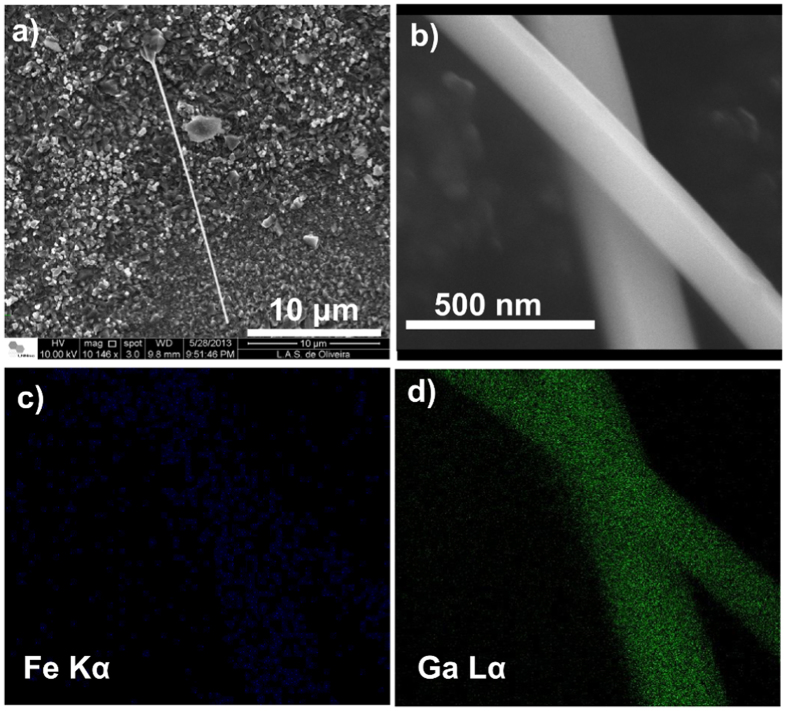
SEM images of (a) an isolated nanowire, (b) two nanowires of Fe3Ga4. EDS composition mapping related to (c) Fe Kα and (d) Ga Lα energies.